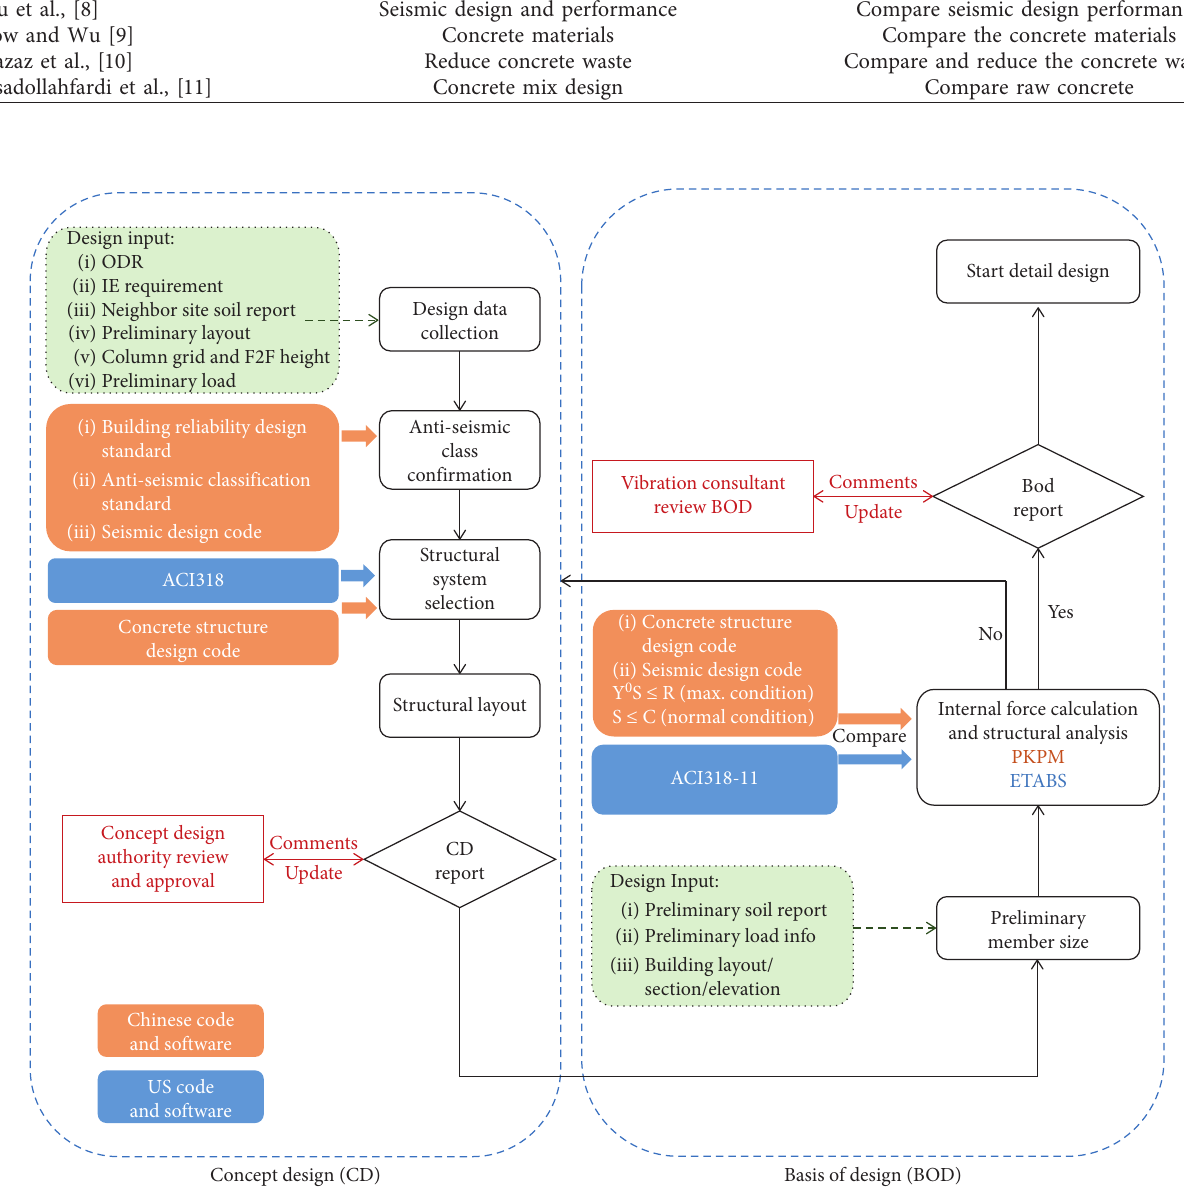
Figure 1: Comparison of preliminary design processes pertaining to the Chinese and American codes.